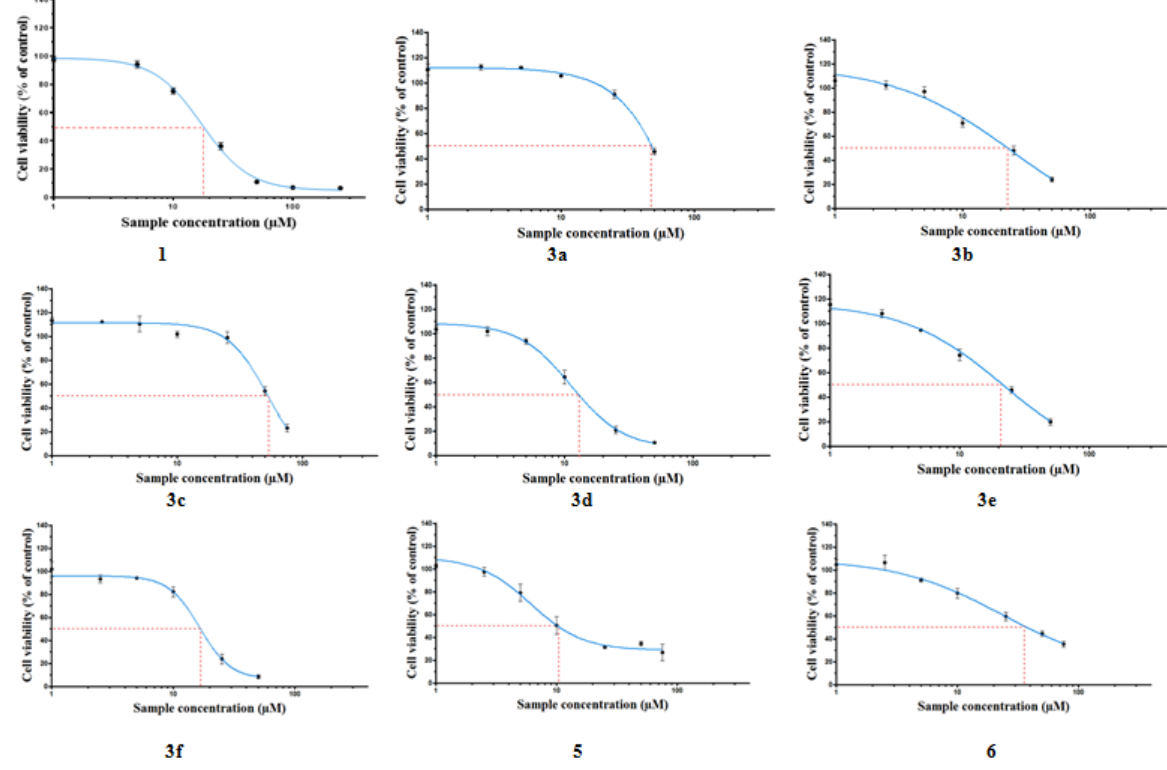
Figure 2: Antiproliferative effect of the samples on HeLa cells. [ 3a : P<0.0001, R2=0.943; 3b : P<0.0001, R2=0.922; 3c : P<0.0001, R2=0.945; 3d : P<0.0001, R2=0.964; 3e : P<0.0001, R2=0.956; 3f : P<0.0001, R2=0.945; 5 : P<0.0001, R2=0.911; 6 : P<0.0001, R2=0.934. Starting compound 1 : P<0.0001, R2=0.982. Data are mean ±SD of percent changes compared with untreated controls